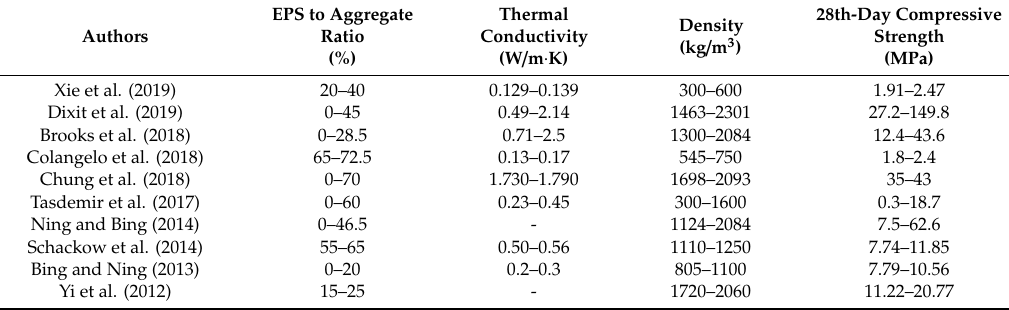
Table 1. Contemporary works on insulating concrete with EPS